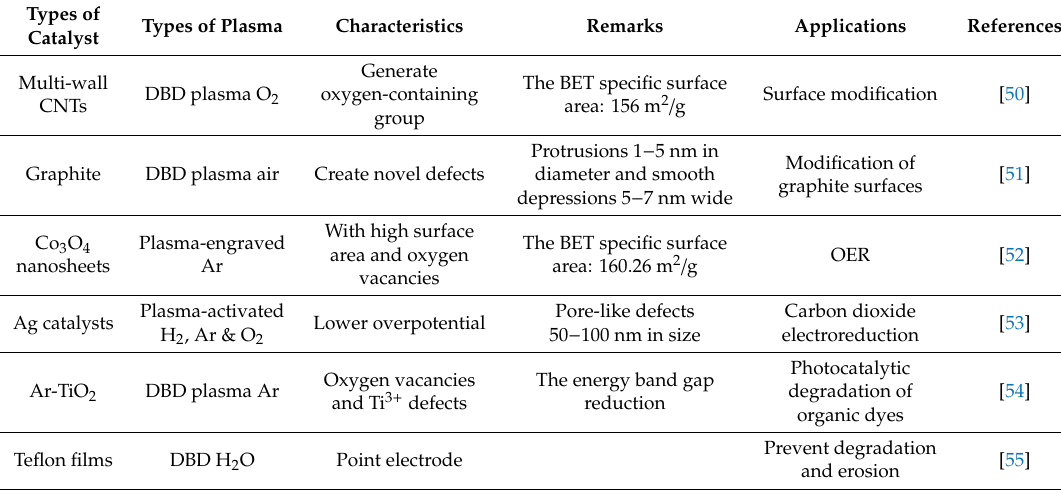
Table 2. Defect-rich catalysts prepared by a plasma